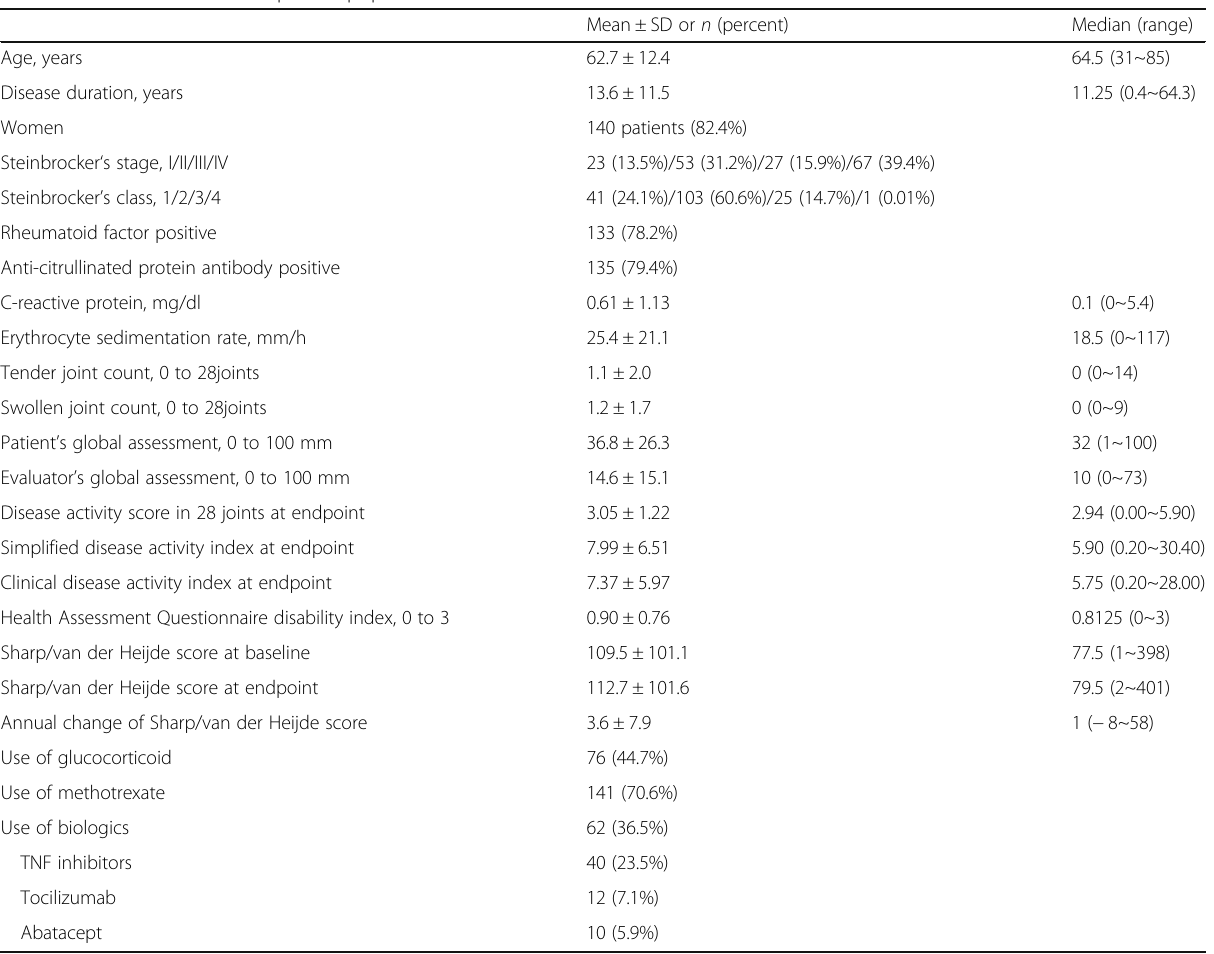
Table 1 Characteristics of the patient population